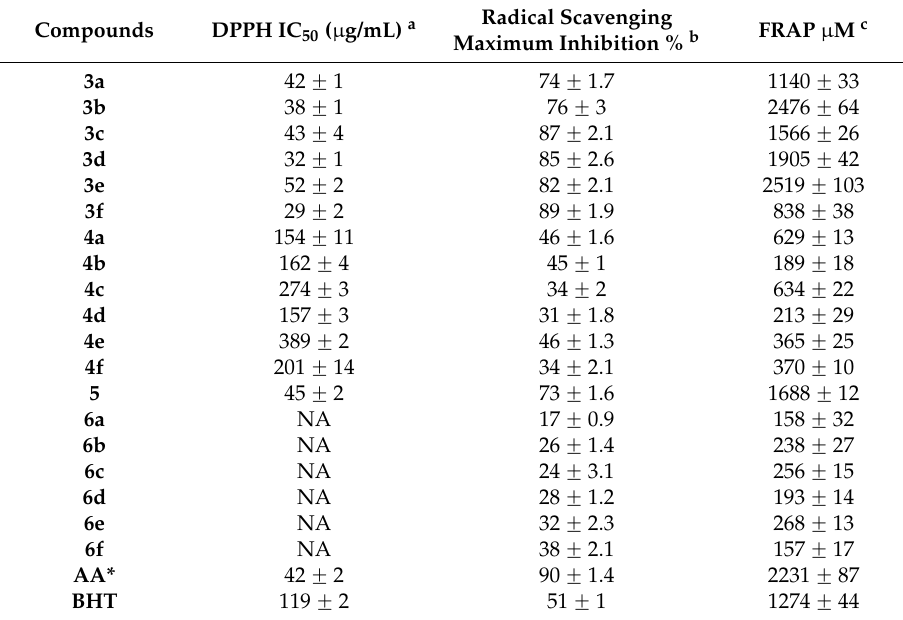
Table 1. DPPH radical scavenging activity and FRAP values of the synthesized compounds.